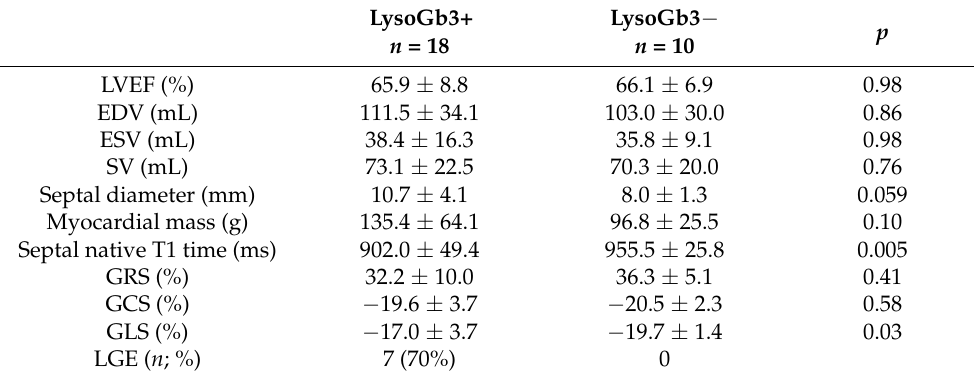
Table 3. Correlations of strain values, LysoGb3, myocardial mass and native T1. Table 4. Cardiac function and morphology: FD Lyso-Gb3+ versus Lyso-Gb3-.